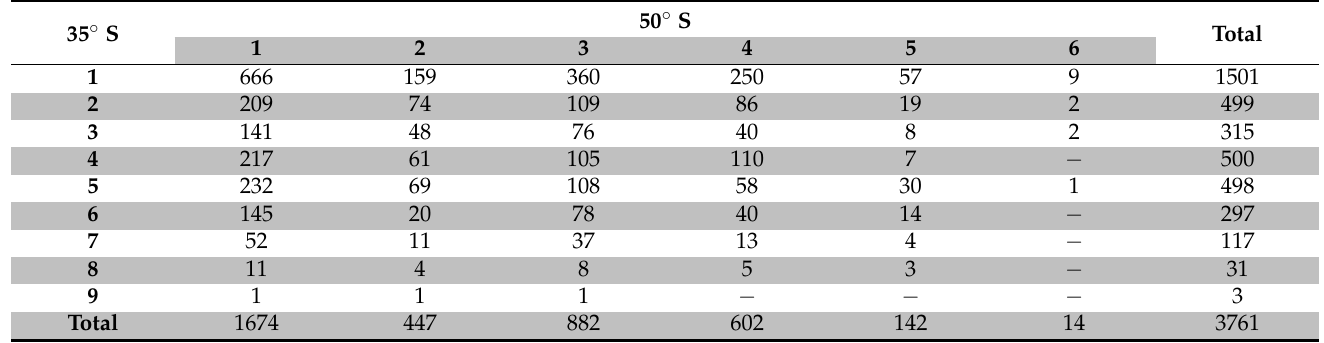
Table 1. Annual counting of the combination of the zonal waves that had the single maximum represented variance at 35 ◦ S and 50 ◦ S on the dates when blocking conditions were fulfilled at least in 1 of the 144 analyzed longitudes. The number of dates totaled